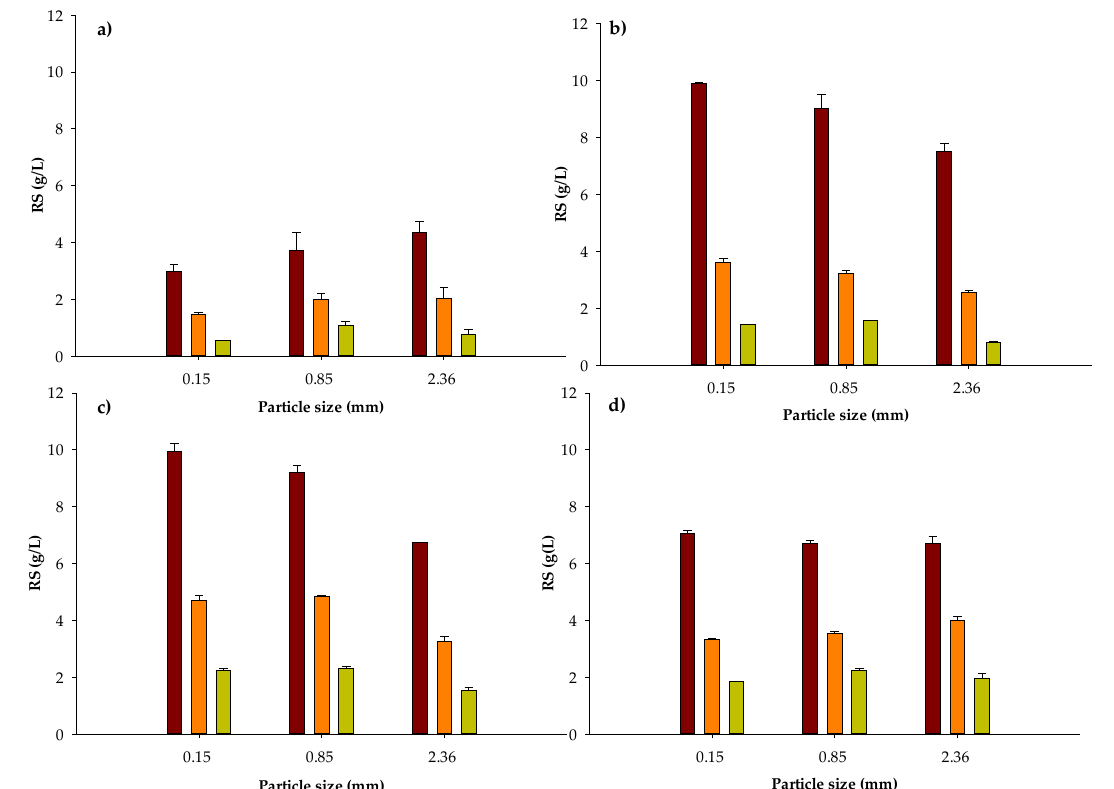
Figure 1. Released RS after thermo-chemical pretreatment of water hyacinth biomass at different particle sizes (0.15, 0.85 and 2.36 mm), reaction times (( a ) 10 min, ( b ) 20 min, ( c ) 40 min and ( d ) 60 min) and solid loading (50 ■ , 20 ■ and 10 ■ g water hyacinth biomass/L H 2 SO 4 3% w/w ). Data represent the mean and the standard deviation of three assays.